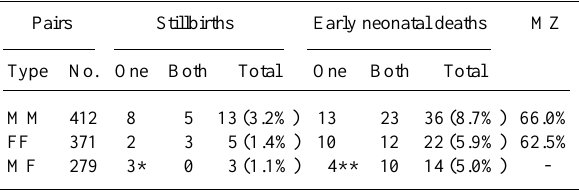
Table IV - Stillbirths and early neonatal deaths among MM, FF and MF twin births, and estimates of the proportion of monozygotic pairs (MZ) among like-sex pairs.